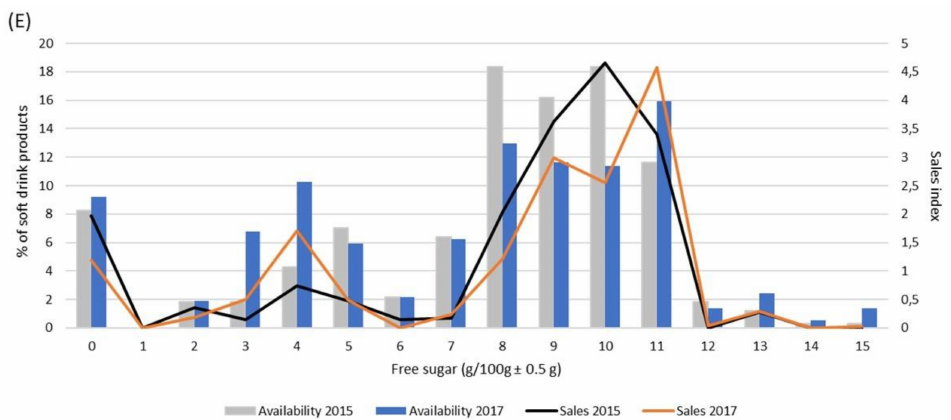
Figure 4. The comparison between the availability and sales of food products in relation to the free sugar content in 2015 and 2017. ( A ) Yogurts, ( B ) biscuits, ( C ) breakfast cereals, ( D ) cakes, mu ffi ns and pastry, and ( E ) soft